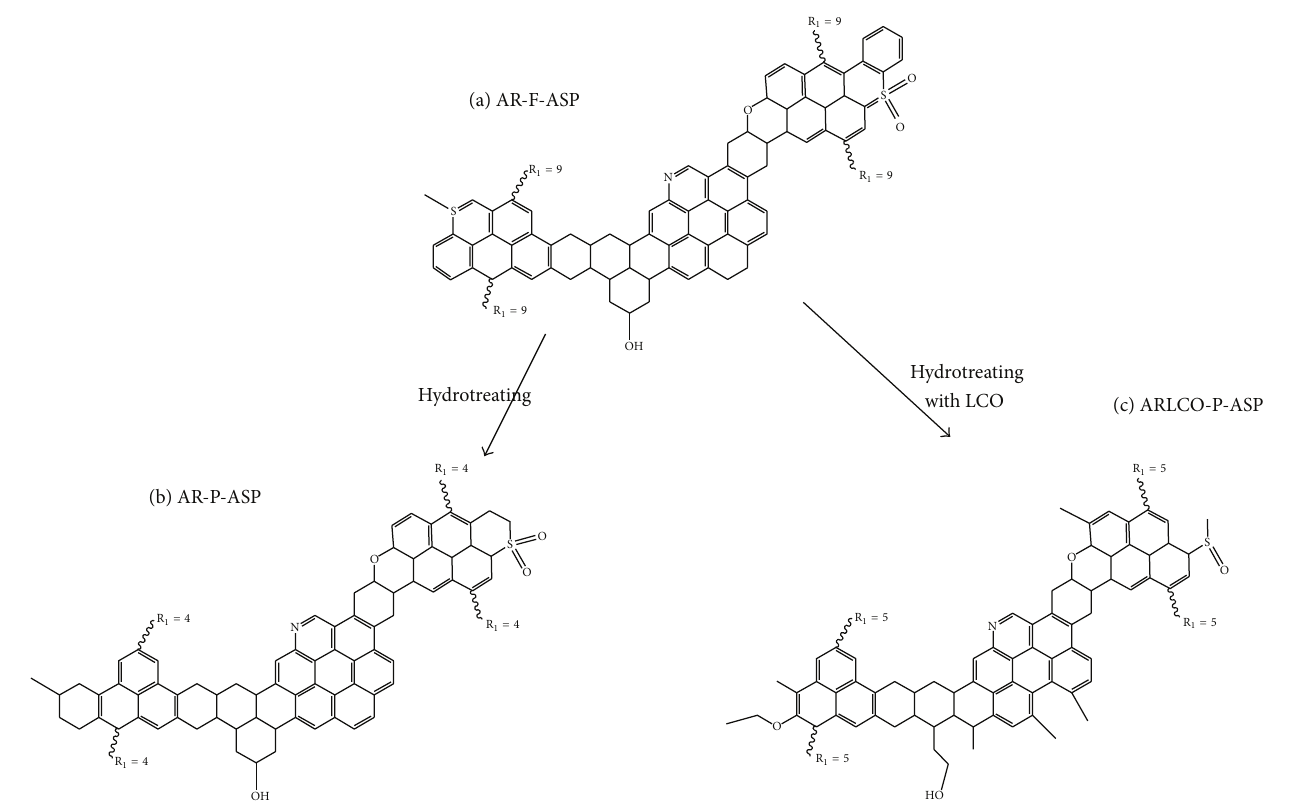
Figure 6: Model structures of asphaltenes’ aromatic